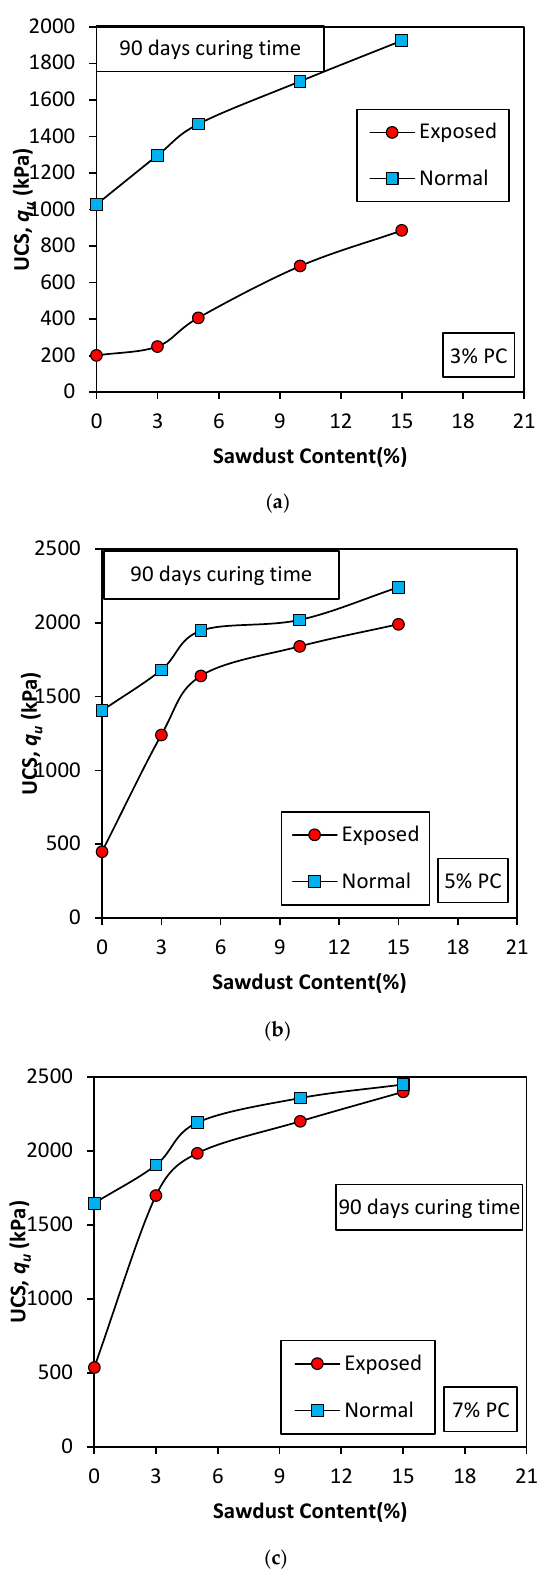
Figure 9. E ff ect of sawdust addition on USC peak values (90 days curing): ( a ) 3% PC; ( b ) 5% PC; ( c ) 7%